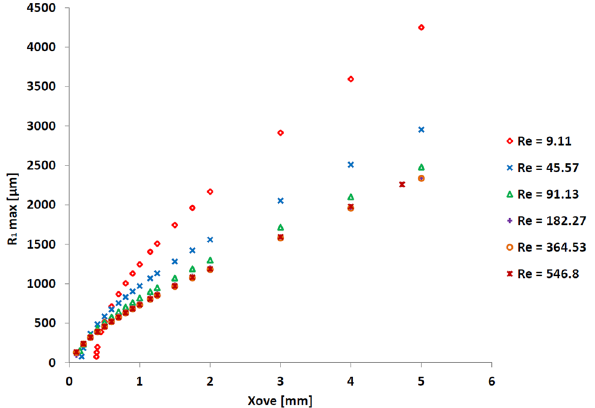
for different values ove = 10 bar pump